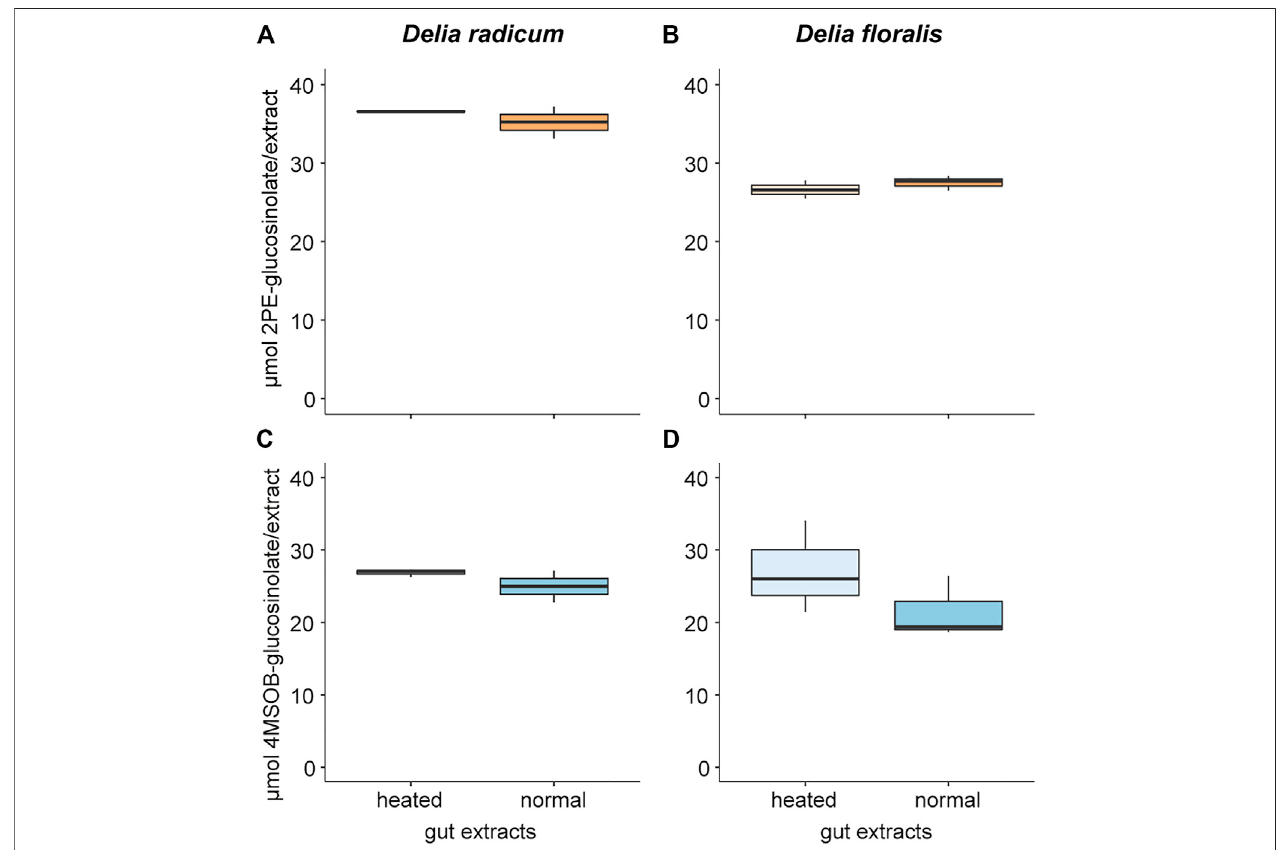
FIGURE 1 | Glucosinolate concentration degraded by gut extracts from Delia radicum (left) and D. fl oralis larvae (right). Guts of 2 nd instar were extracted and either heated or incubated at room temperature (intact) before adding 2-phenylethyl glucosinolate (2PE-GSL) or 4-(methylsul fi nyl)butyl glucosinolate (4MSOB-GSL). (A) 2PE- GSL amount in assays containing extracted guts from D. radicum and (B) from D. fl oralis larvae. (C) 4MSOB-GSL amount in assays containing extracted guts from D. radicum and (D) from D. fl oralis larvae. Each condition was replicated three times with a pool of 10 larval guts.